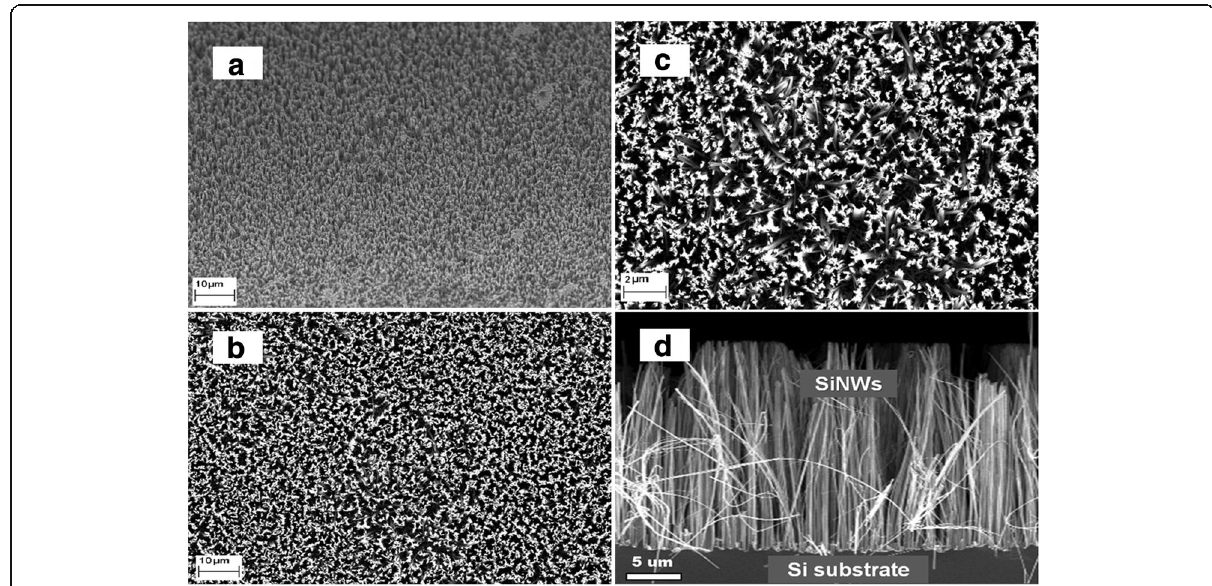
Fig. 3 SEM images of SiNW arrays fabricated via the electroless etching method: a 45° view, b , c top view, d cross-section/side